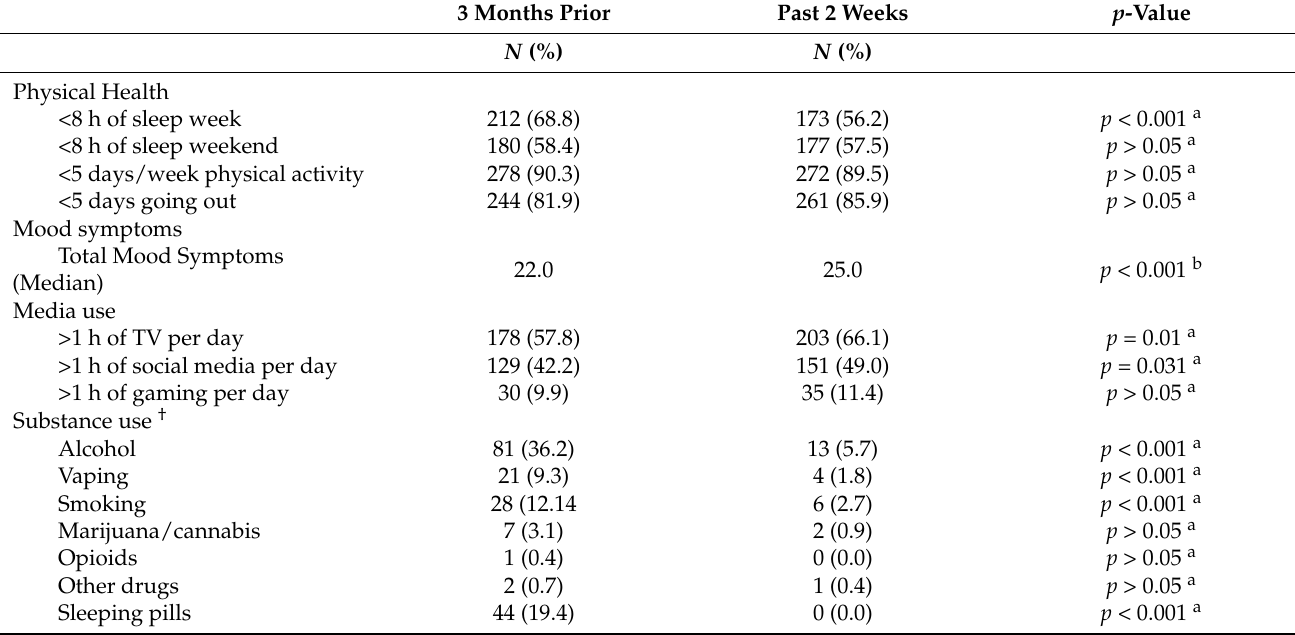
Table 4. Differences in current physical health, substance use, media use, and mental health compared to 3 months prior to COVID-19 ( N = 308).